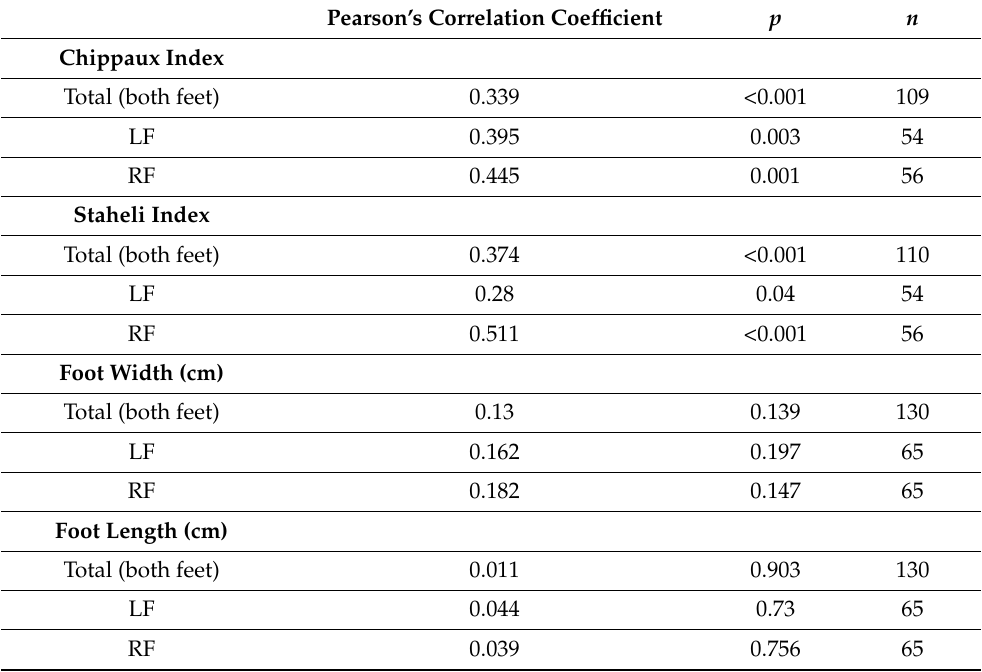
Table 2. Correlation between podiatric measurements for both raters of pedigraph and plat- form pressure.